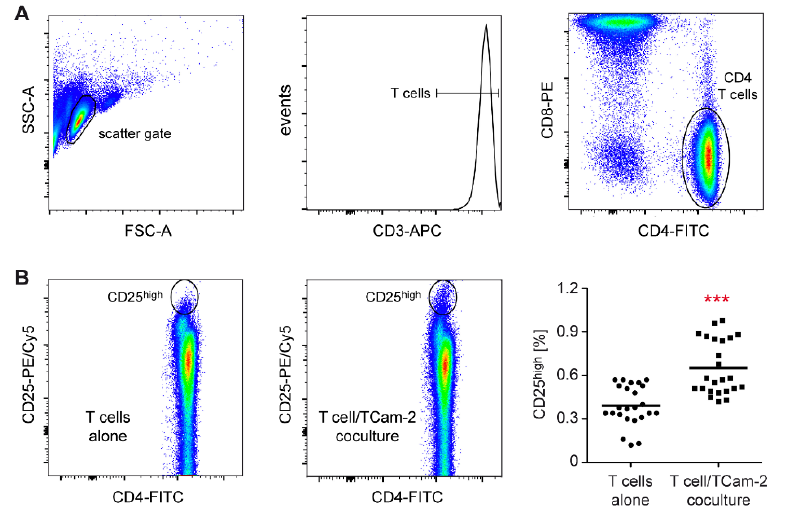
Figure 1. Flow cytometric analysis of peripheral blood T cells cocultured with TCam-2 cells. T cells were isolated from PBMC of healthy blood donors using magnetic cell sorting and cultured in 6-well plates either on a monolayer of TCam-2 cells or alone for 24 h. T cells were collected and stained with fluorochrome-conjugated monoclonal antibodies. ( A ) Exemplary gating strategy for T cell analysis. Relevant cells were initially defined based on their forward and sideward scatters, followed by gating for T cells based on the expression of CD3. T-cell subpopulations were further defined using the cell surface markers CD4 and CD8. ( B ) Activated CD4 + T cells were identified by their high expression of CD25. Exemplary comparison between T cells cultured alone (left panel) and T cells cocultured with TCam-2 cells (middle panel). The right panel depicts the quantification of CD25 high CD3 + CD4 + T cells present in each condition. N = 24; PBMC were obtained from 7 healthy volunteers. Statistical analysis was performed by unpaired t ‐ test (***: p < 0.001).